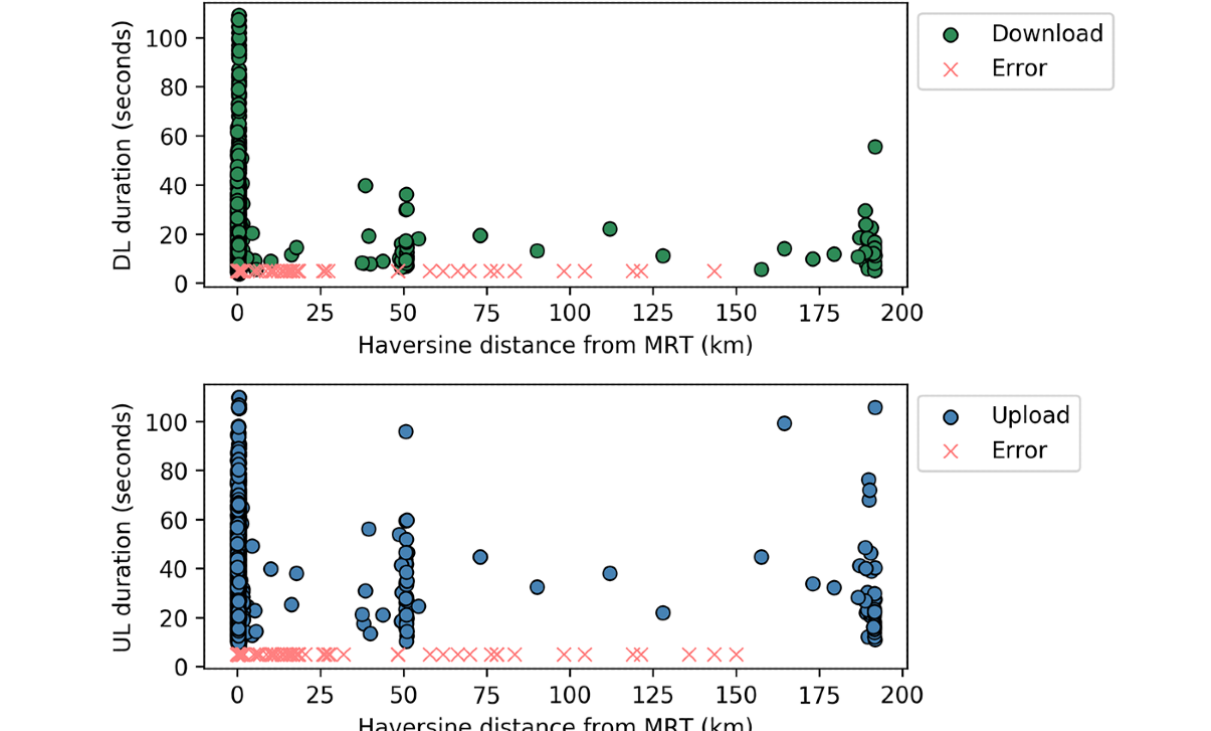
Figure 7. Download (top) and upload (bottom) durations and the errors in each mode as a function of the haversine distance from the Macha Research Trust. DL: download; km: kilometers; MRT: Macha Research Trust; UL: